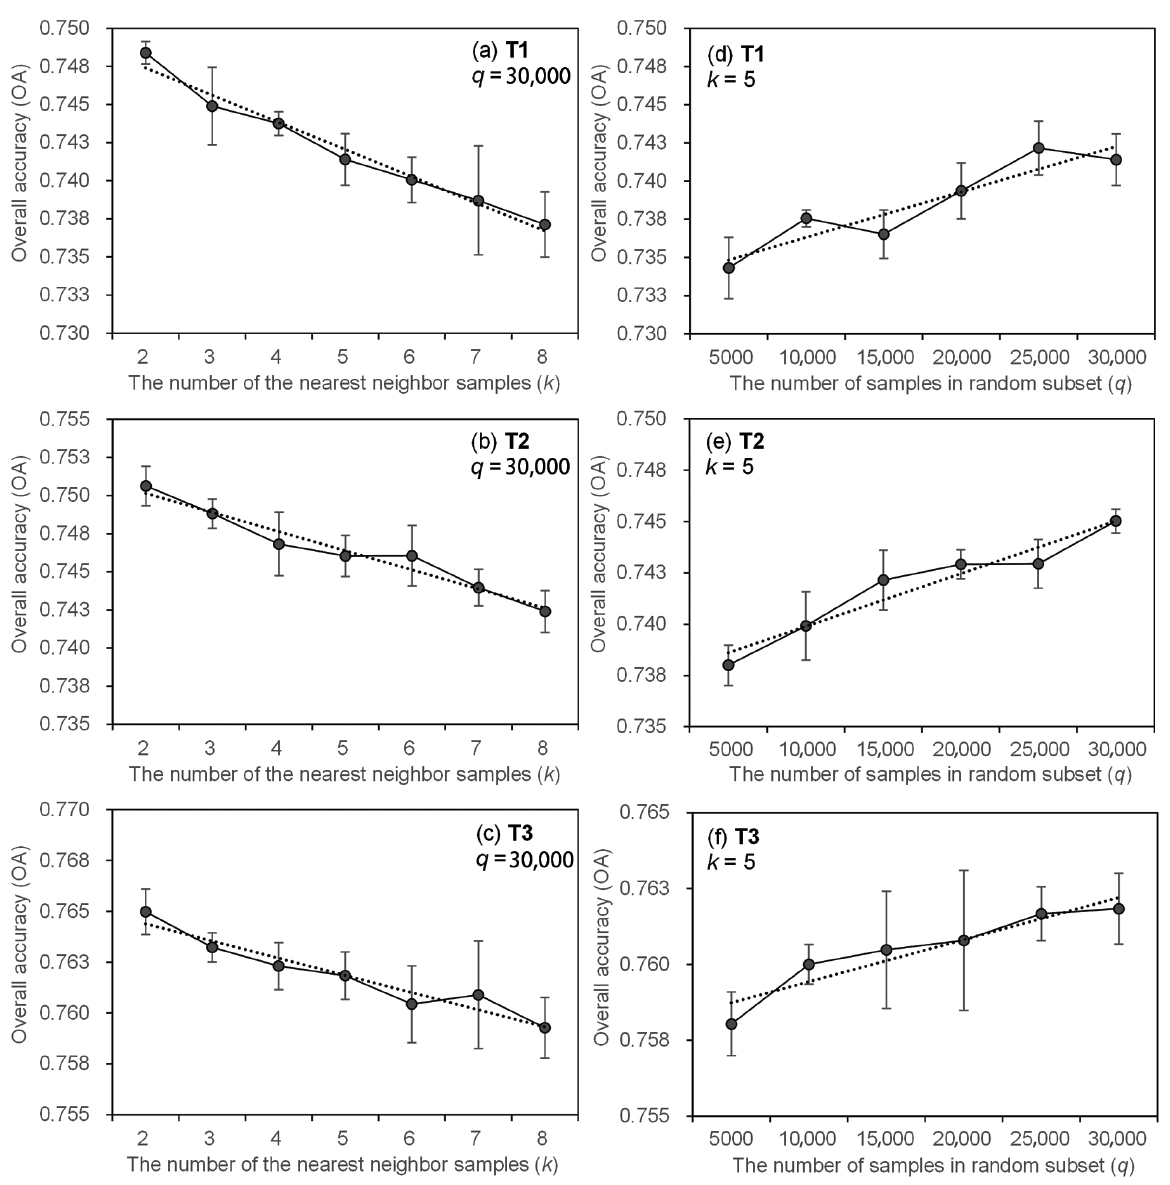
Figure 3. Impact of two hyperparameters on overall accuracy (OA) in three sub-training sets. ( a – c ) are representative of the change of OA as the number of the nearest neighbor samples ( k ) increase in sub-training set T1 , T2 , and T3 , respectively. ( d – f ) are representative of the change of OA as the number of samples ( q ) increase in sub-training set T1 , T2 , and T3 , respectively. All data are mean ± standard error from five measurements, and the dashed line shows a linear correlation between OA and each